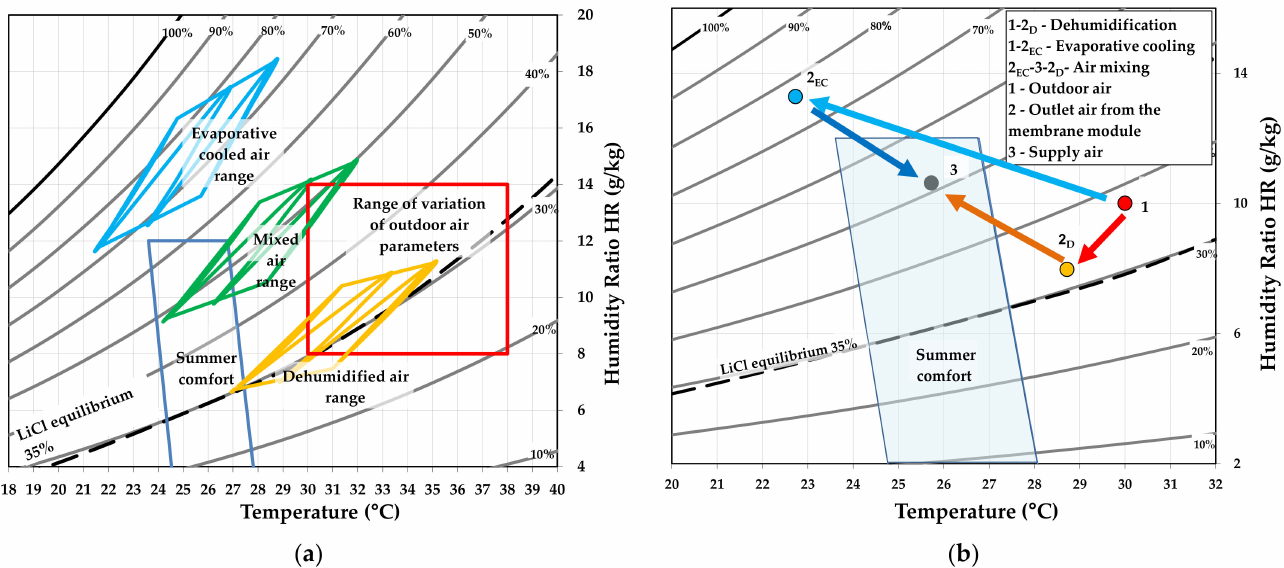
Figure 8. Psychrometric chart for the evaporative cooling, dehumidification, and air mixing processes: ( a ) for the whole analyzed range of the outdoor air; ( b ) for one initial